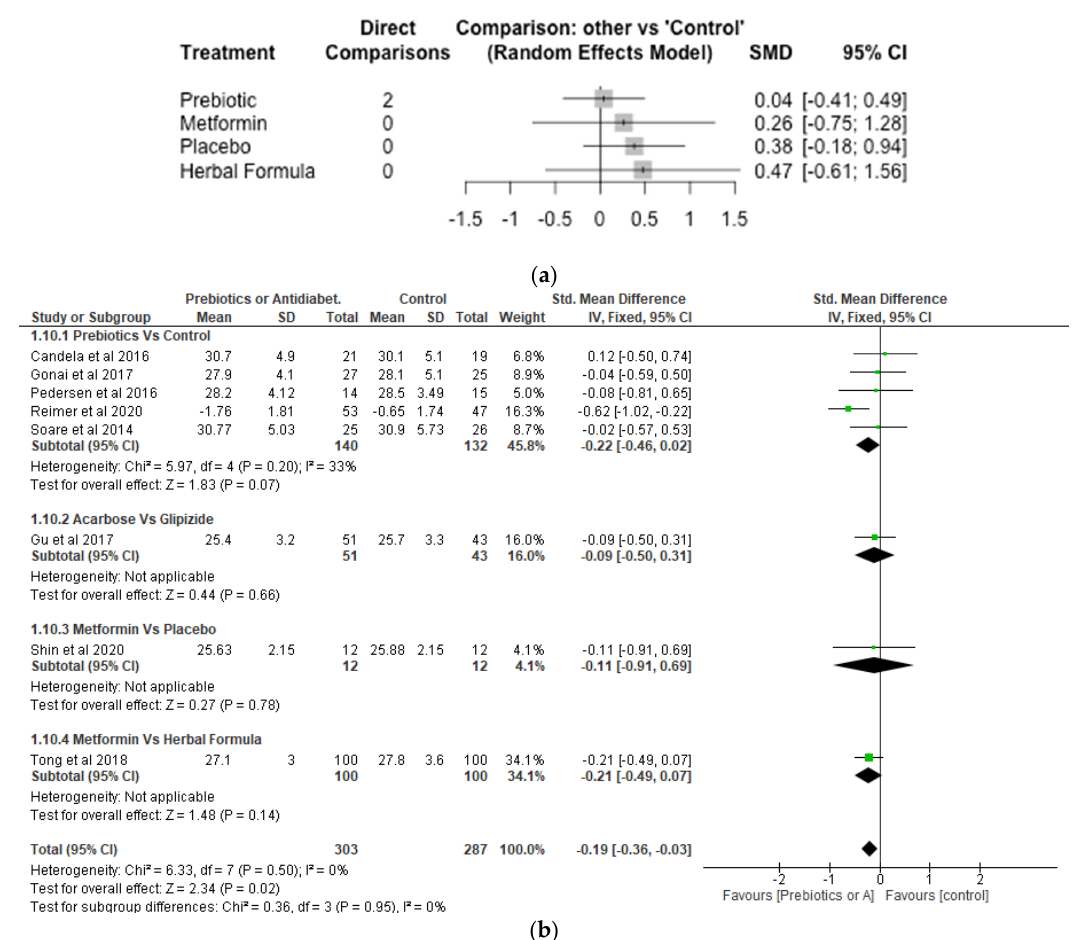
Figure 9. Network Meta-analysis ( a ) and Meta-analysis ( b ) of the effect of treatments versus control on Body Mass Index [32,38–43,46].